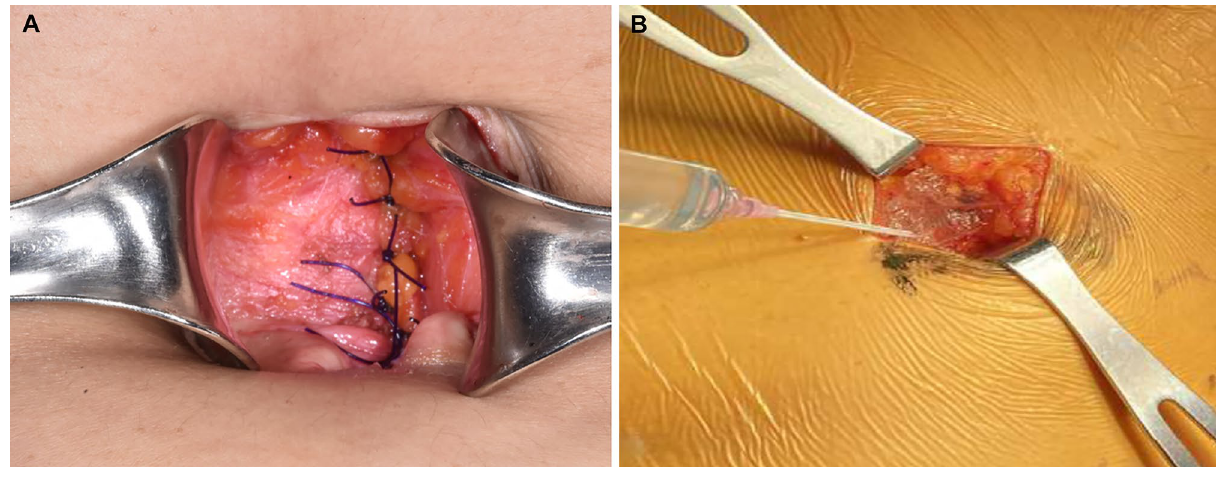
Figure 6. Application of Gel at the wound